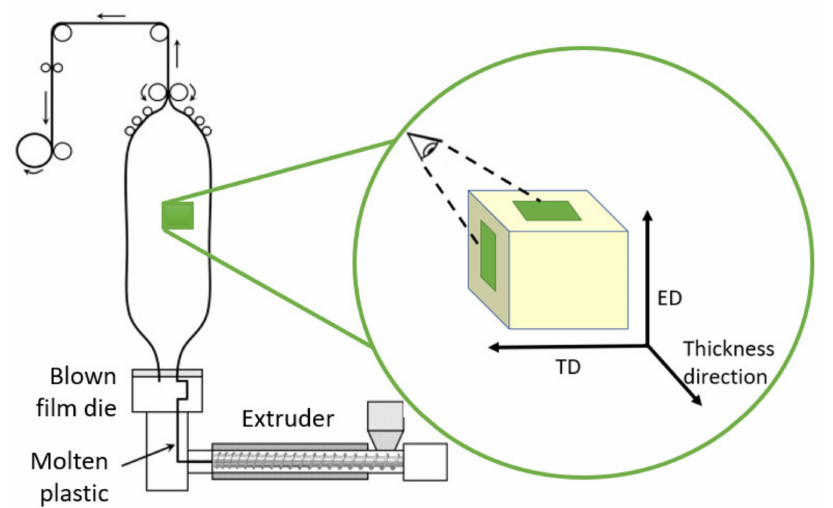
Figure 1. Sample orientation with respect to extrusion direction (ED), transverse direction (TD), and thickness directions; ED shows a TD-thickness direction-plain, and TD shows an ED-thickness